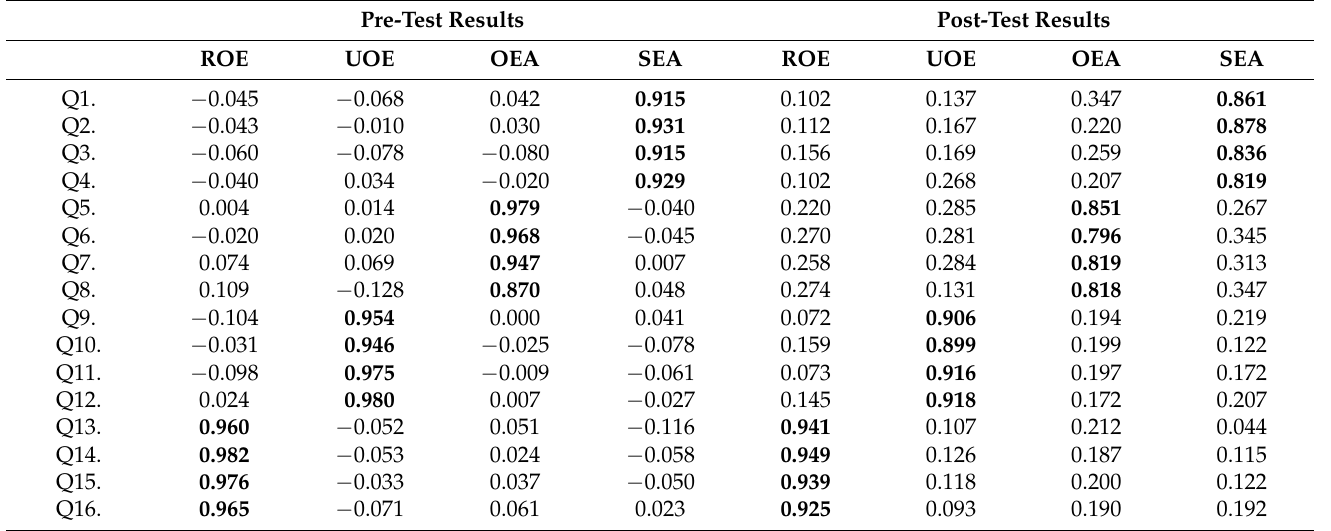
Table 3. Results of Exploratory Factor Analysis of items on the Wong and Law Emotional Intelligence Scale WLEIS (N =